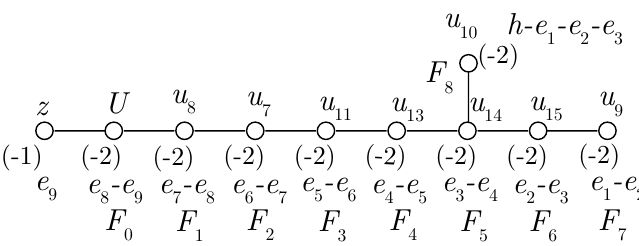
Figure 5 . The negative curves on the vertical divisor gdP 9 , where the numbers in the brackets denote the self-intersection numbers and the letter u i or z indicates the intersection of that divisor in the resolved Calabi-Yau with S = gdP . We also denote the expression of each curve in terms 9 of the standard basis of the Picard group h and e i of a rational